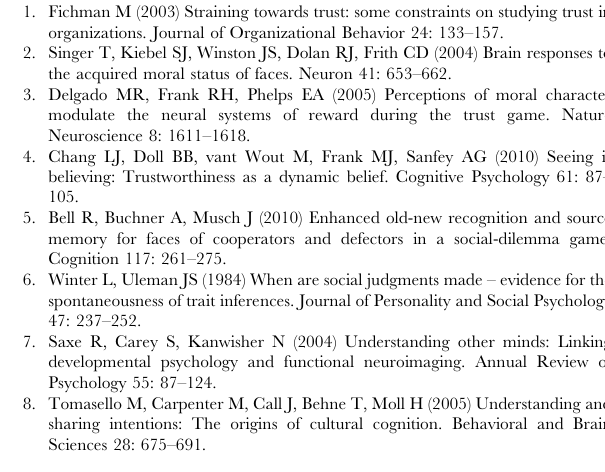
Table S6 As is consistent with the gender difference in the pre-game partner judgment, a simple main effect test revealed that male participants invested more to a high MR partner and less to a low MR partner than did female participants. Table S7 Summary of fit statistics by a series of SEM. Table S8 Items in Partner